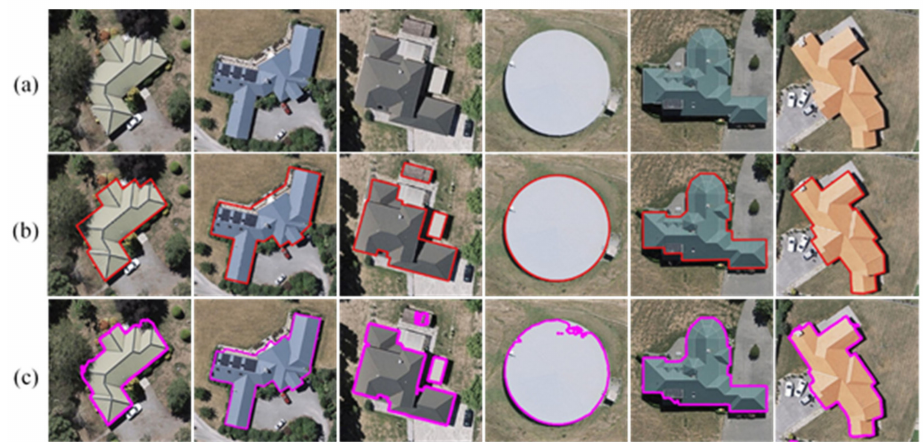
Figure 14. Results of building edge extraction on the RSIBE dataset. ( a ) Images. ( b ) Labels. ( c ) Results.